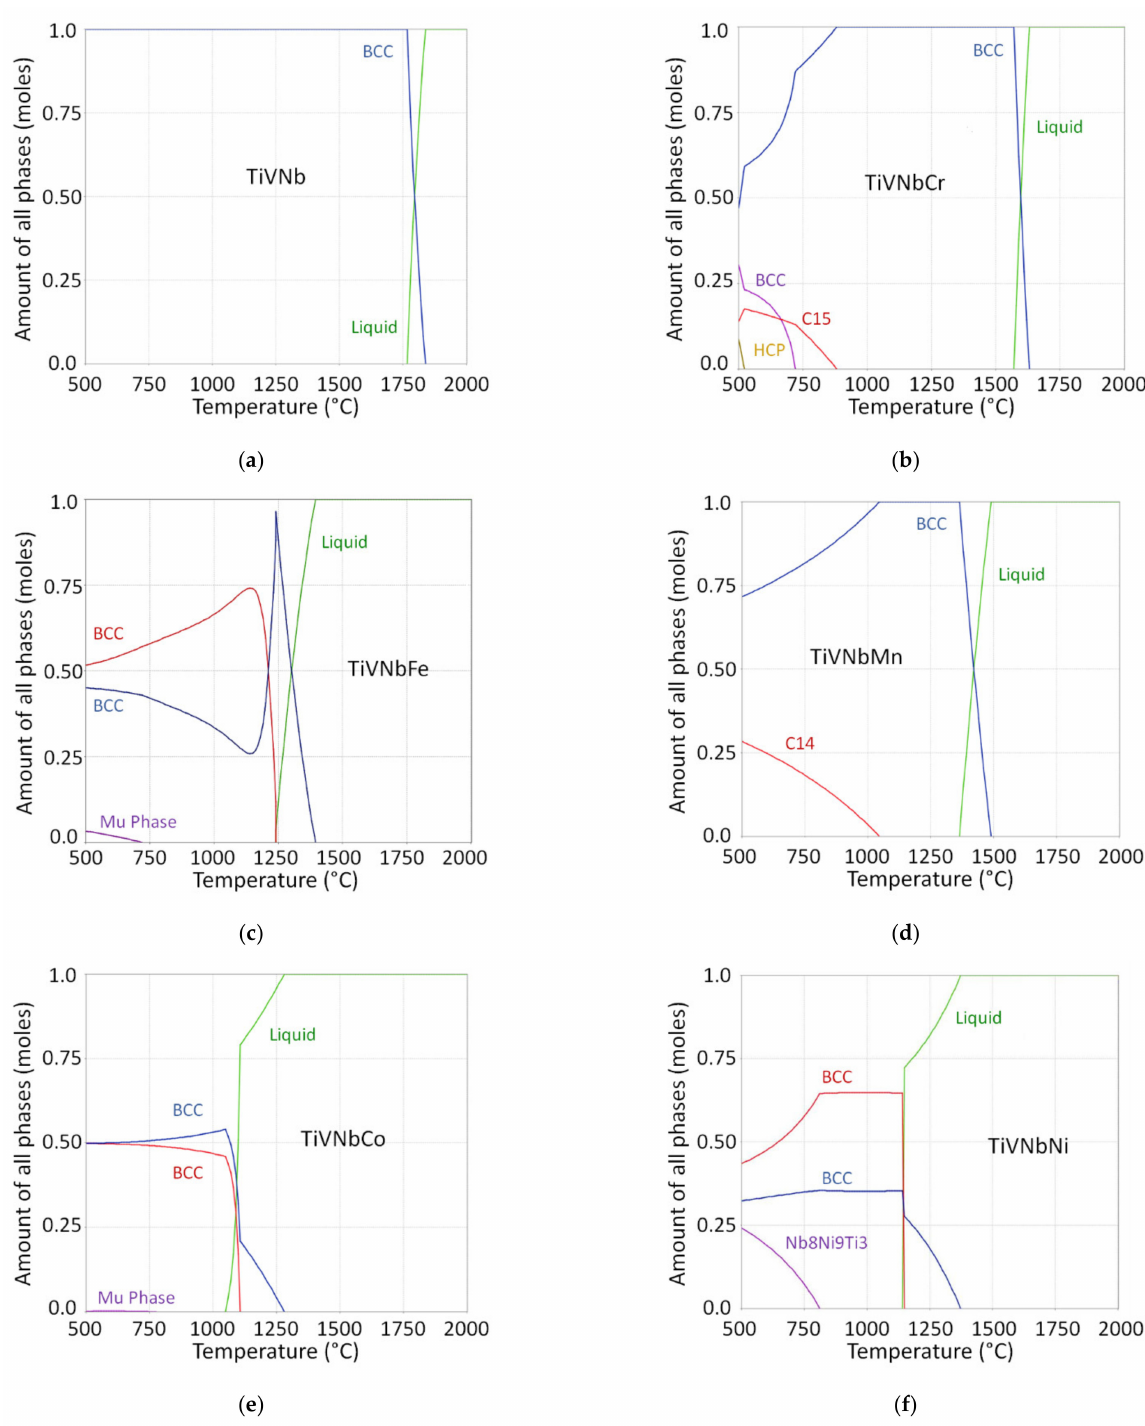
Figure 1. Thermodynamic calculation of the TiVNbT (T = Cr, Mn, Fe, Co and Ni) system. Amount of equilibrium phases against temperature. TiVNb ( a ), TiVNbCr ( b ), TiVNbFe ( c ), TiVNbMn ( d ), TiVNbCo ( e ) and, TiVNbNi ( f ). The phase indicated by Mu is a topologically close pack (TCP) phase; W 6 Fe 7 prototype (space group